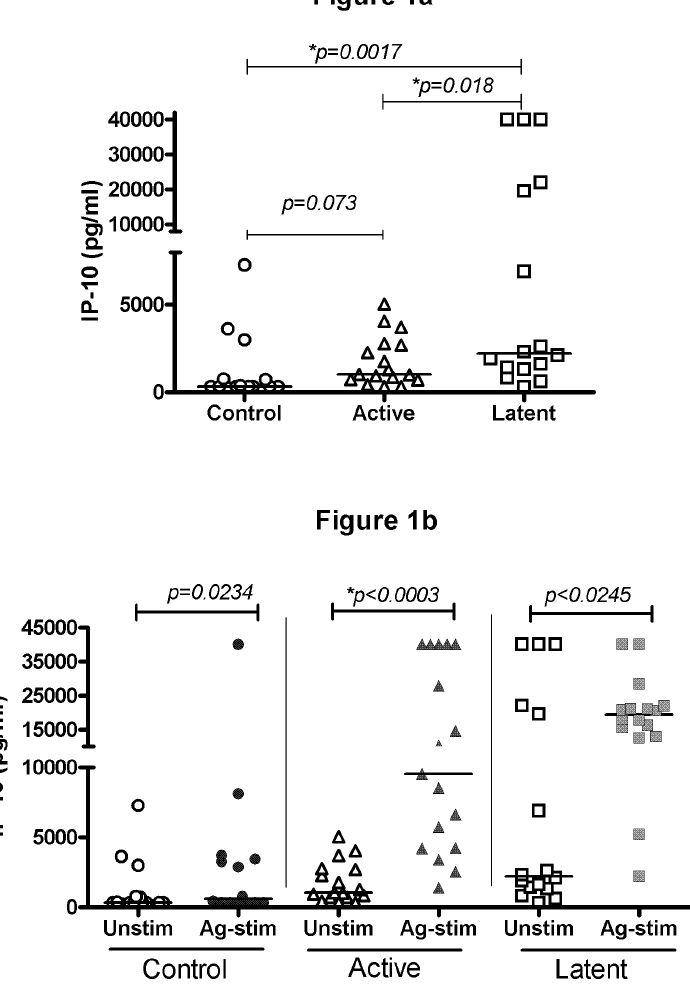
Figure 1. Concentration of IP-10 (pg/ml) in supernatants from: a) whole blood samples incubated with negative control antigen (background); b.) whole blood samples incubated with TB-specific antigens and negative control antigen, of children with active TB (n=17), LTBI (n=16) and a control group (n=16). Horizontal lines indicate median values. Controls are represented by # , active TB by n , and LTBI by % . Open symbols represent unstimulated, closed symbols represent antigen-stimulated